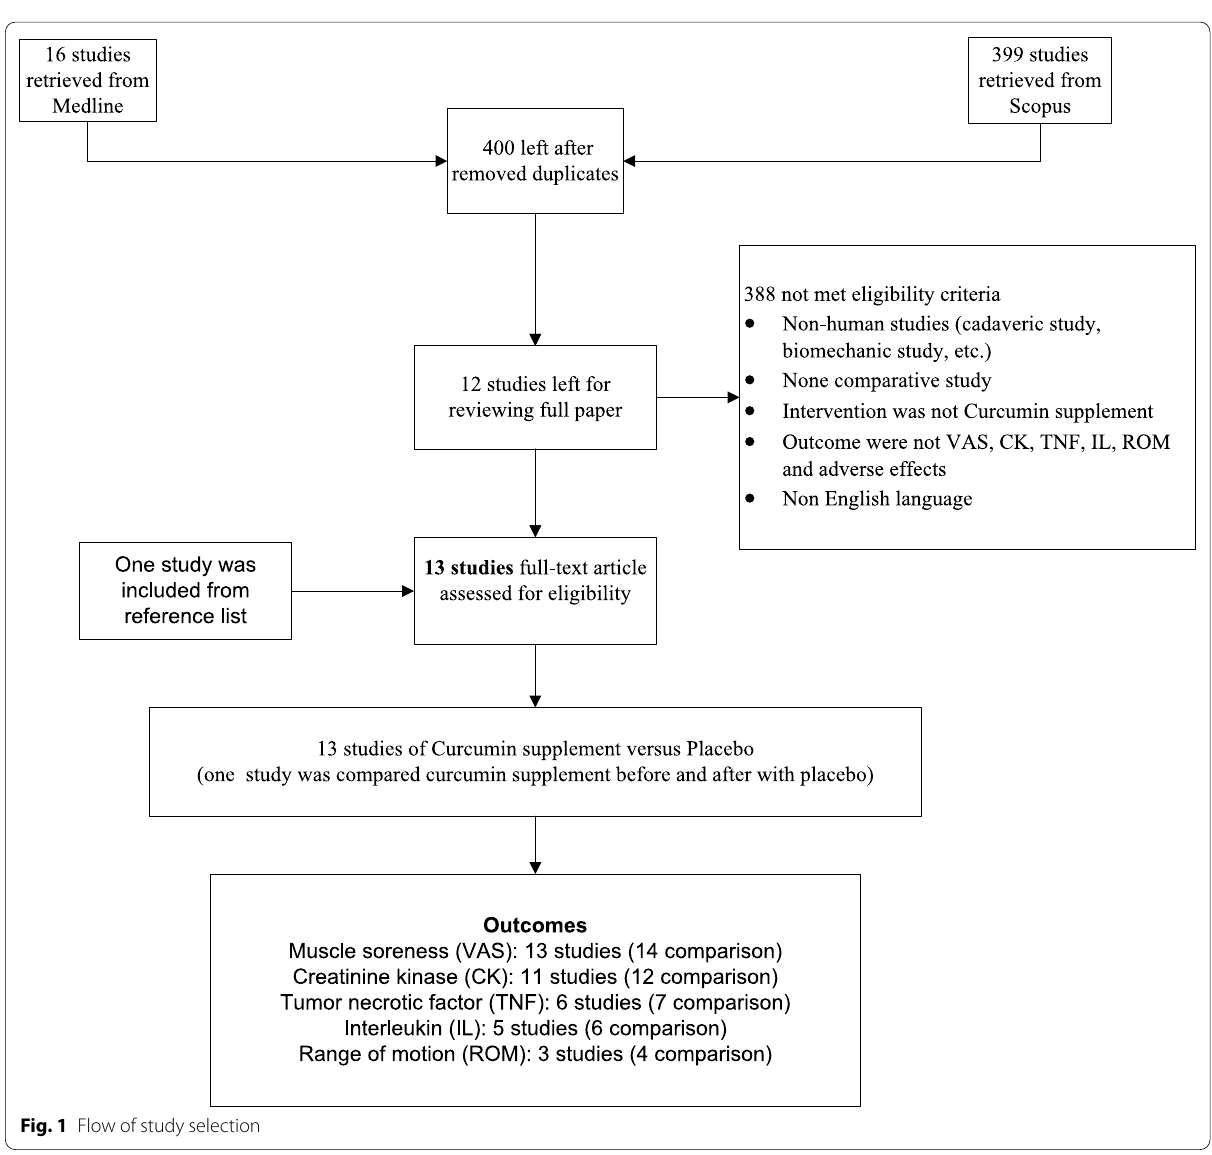
(ROM), swelling, DOMS and an increase in blood mus- cle proteins, including creatine kinase (CK) activity (Clarkson et al. 1992; García-López et al. 2007; Tiidus 1998; Warren et al. 1999; Takahashi et al. 1994). Muscle function impairment caused by damaged and its subse- quent inflammatory responses may reduce the ability to perform daily training and reduce athletic performance. Therefore, post-exercise muscle damage should be pre- vented or minimized (Tanabe et al. 2019). At present, multiple strategies have been treated to attenuate DOMS such as hyperbaric oxygen, anti-inflammatory medica- tion, massage, cryotherapy, homeopathy, stretching, electrotherapeutic modalities, ultrasound, rest, and